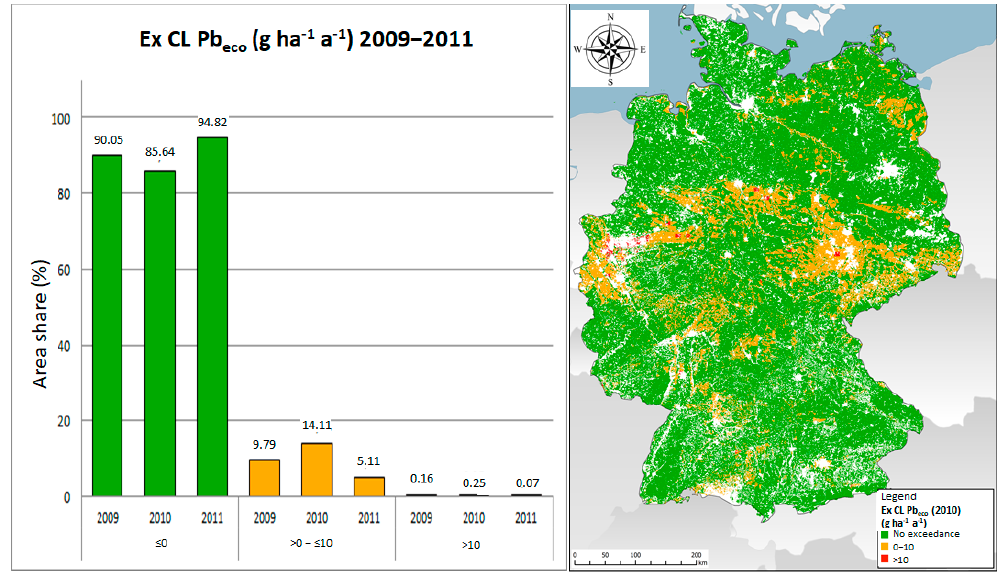
Figure 4. Exceedance of Critical Loads with the aim of protecting ecosystem integrity by atmospheric Pb deposition.